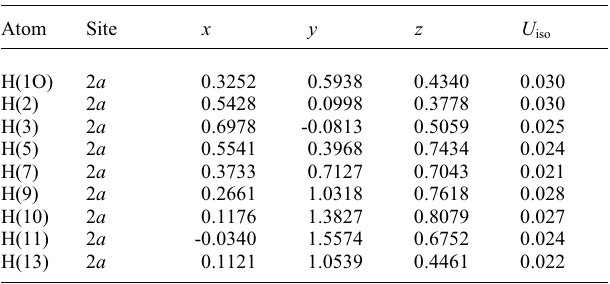
Table 2. Atomic coordinates and displacement parameters (in Å 2 )